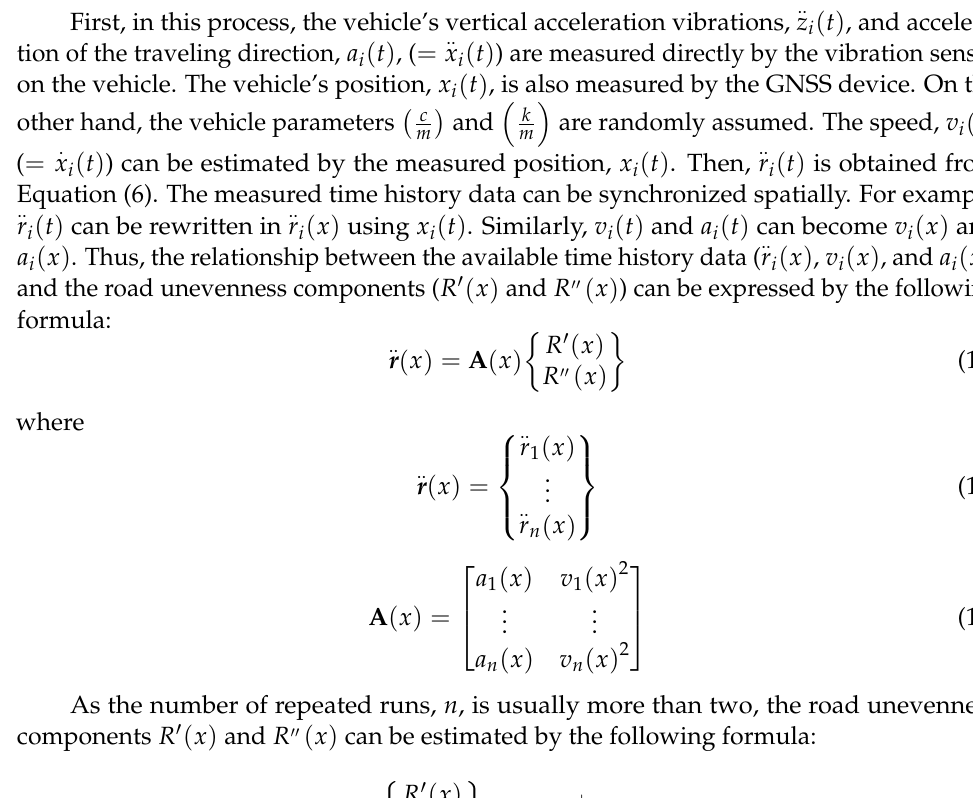
Figure 7. Flowchart of the proposed method of estimating road unevenness components R (cid:48) ( x ) and R (cid:48)(cid:48) ( x ) without prior information about the vehicle parameters require the vehicle’s prior information and can also estimate